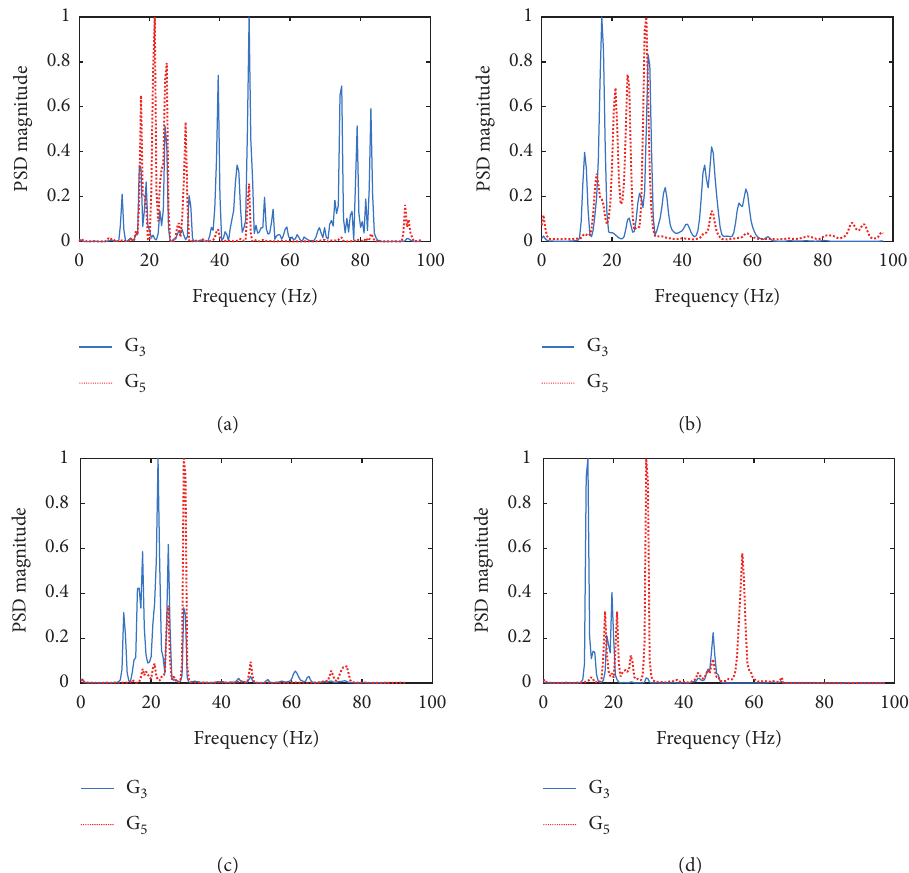
Figure 14: Normalized PSDs measured at A3 and A5 locations with the progression of damage: (a) undamaged, (b) 0.5%, (c) 2%, and (d) 4% drift